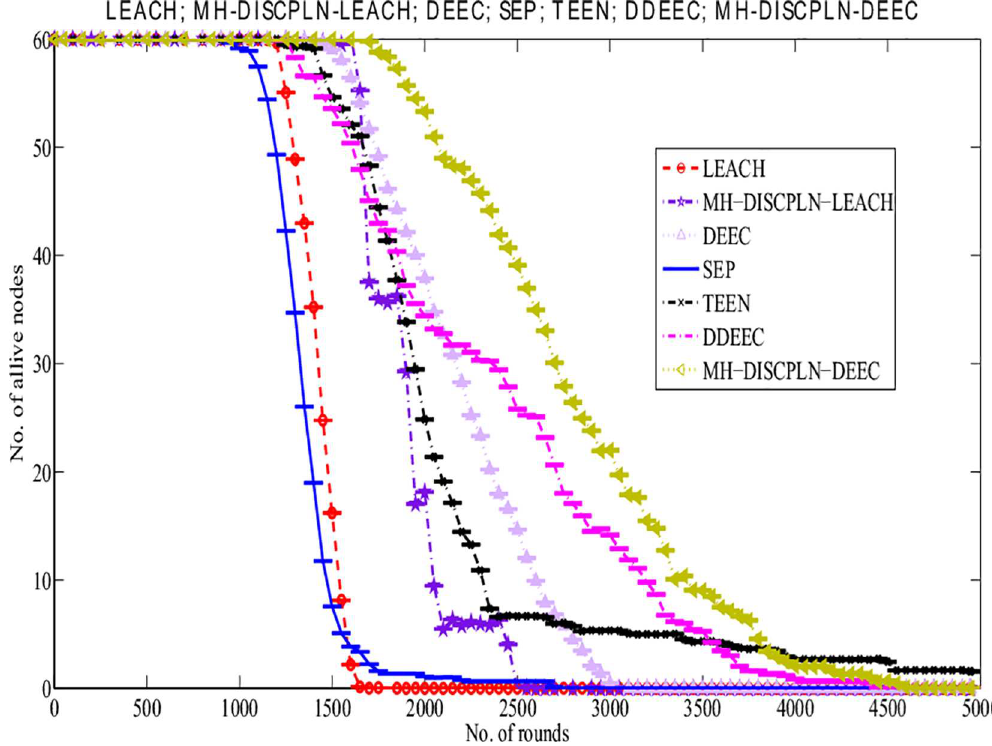
Fig 11. Performance comparison basedon networkstabilityperiodfor multi-hopcommunication.